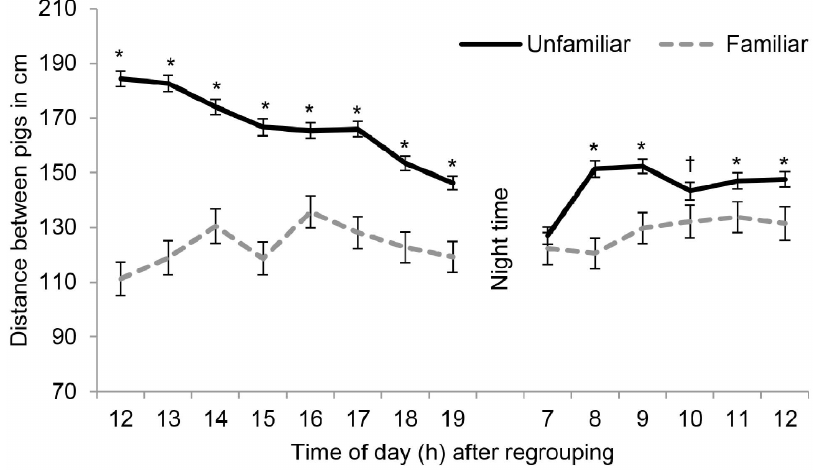
Figure 3. Familiarity affects distance till at least 24 h after encounter. Distance between familiar pigs and their average distance to the four unfamiliar pigs over the course of 24 hour after regrouping, n 5 192 pig